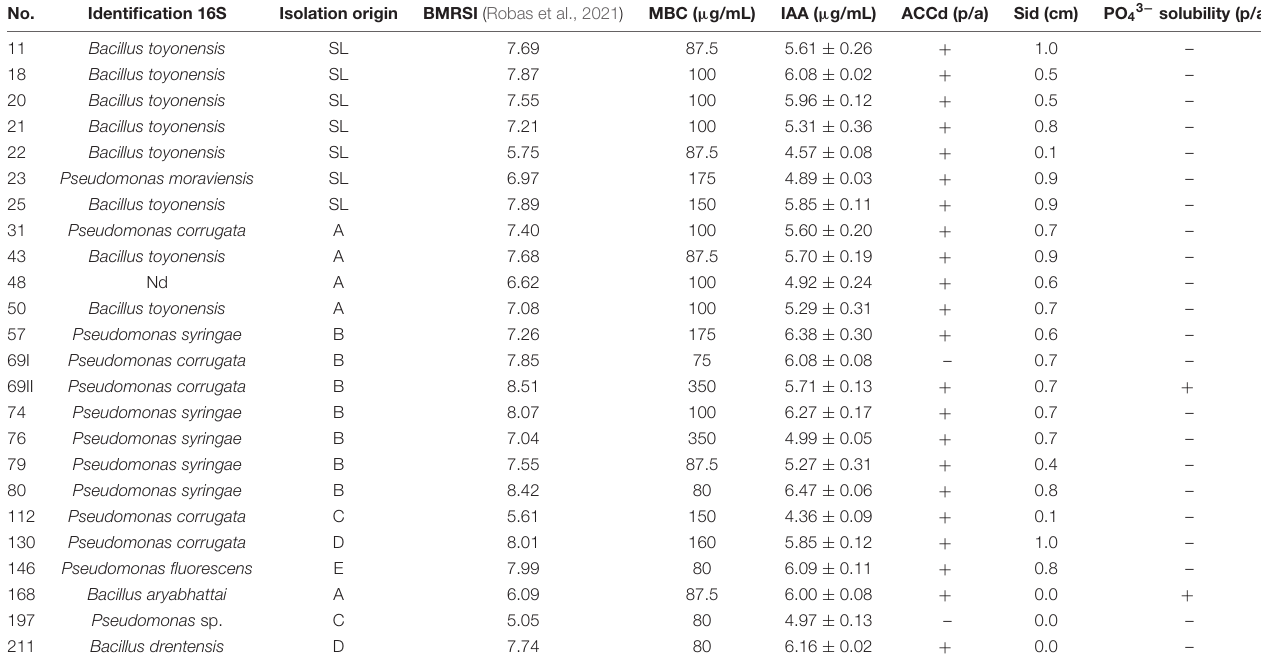
TABLE 1 | Plant growth promoting bacteria (PGPB) characteristics of the tested strains.